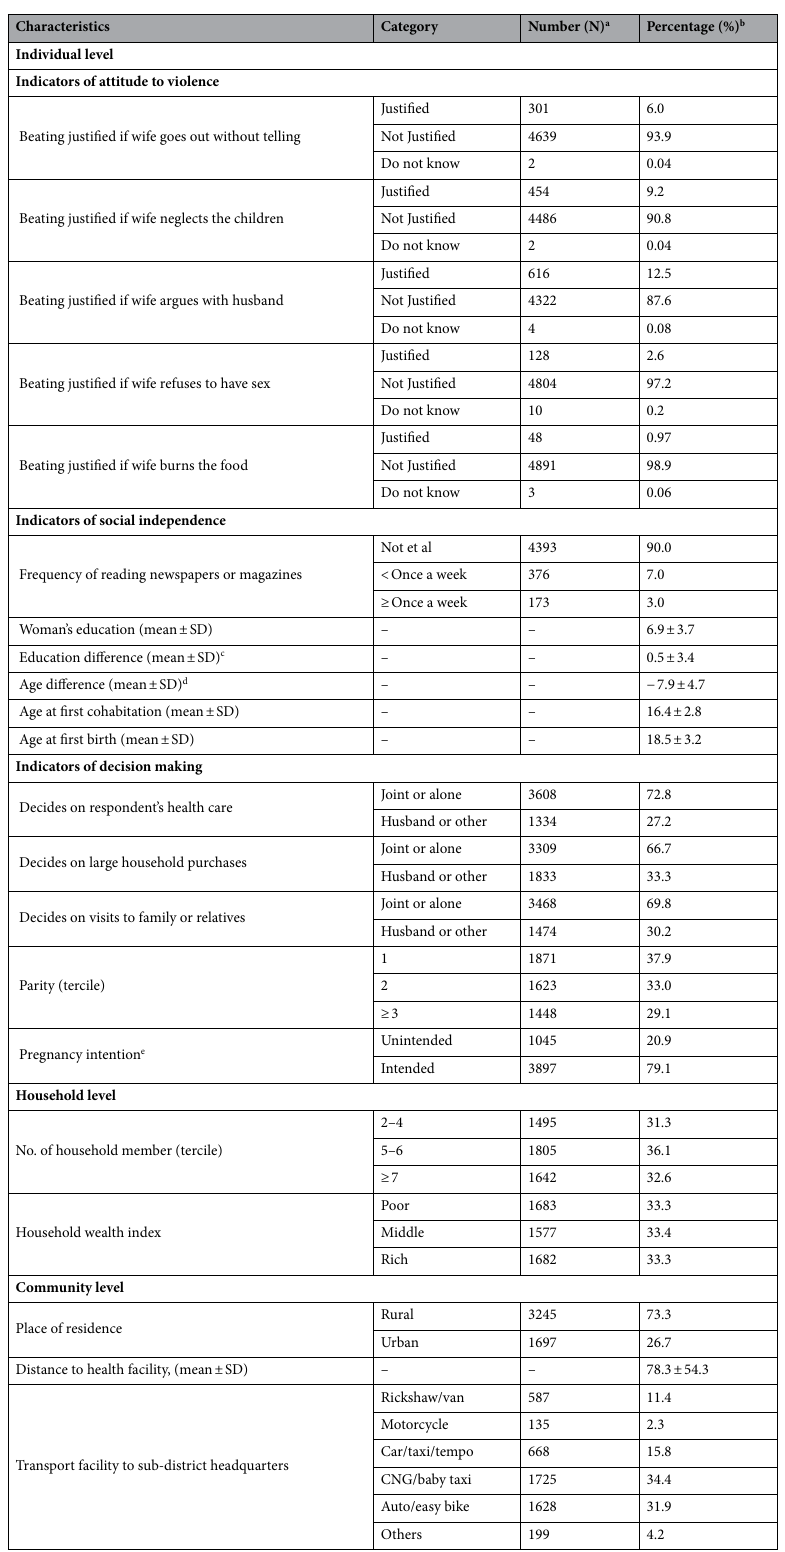
Table 1. Descriptive of individual, household, and community level characteristics of women who had a birth in the past 3 years preceding the survey: Bangladesh Demography and Health Survey 2017–2018 (n = 4942). wanted after conception or not wanted at